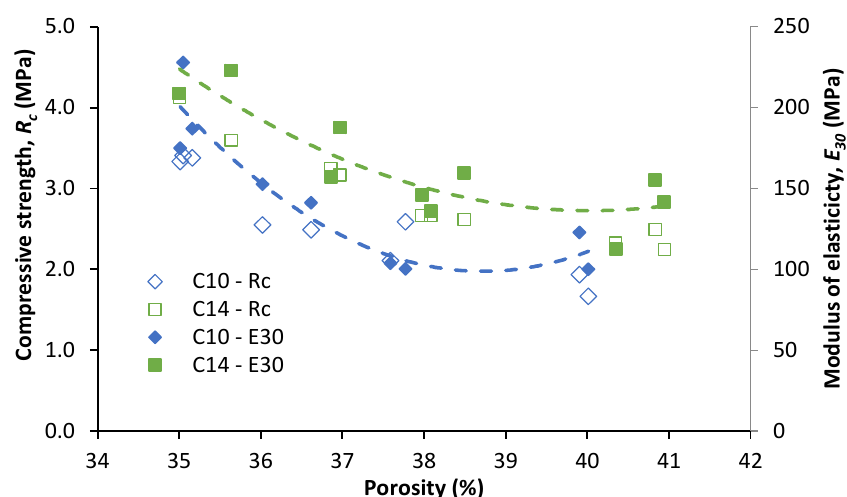
Figure 9. Effect of porosity on unconfined compressive strength and modulus of elasticity.